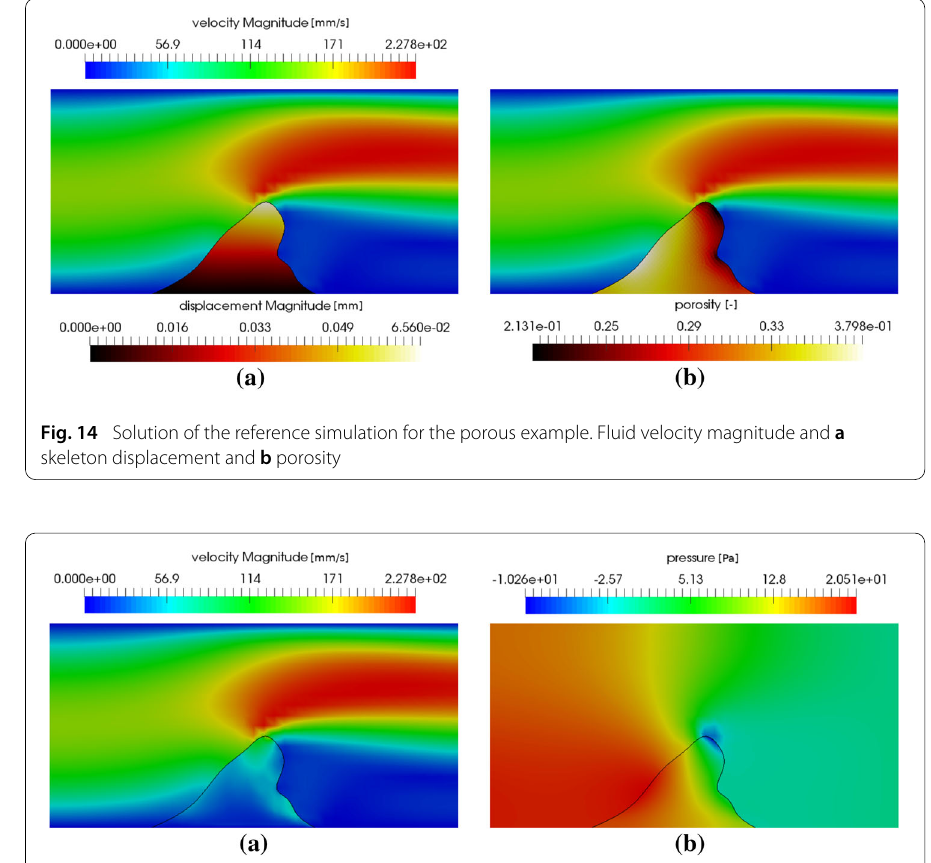
mation one measurement point is chosen on the lower right bump of the geometry. On that basis the inverse analysis is conducted for different initial guesses listed in Table 5. The paths in parameter space are shown in Fig. 17, wherein each marker represents one Levenberg-Marquardt iteration. For two initial guesses, namely the blue and green line, the algorithm converges to the reference parameters and for one initial guess, displayed in orange, the algorithm had to be terminated without